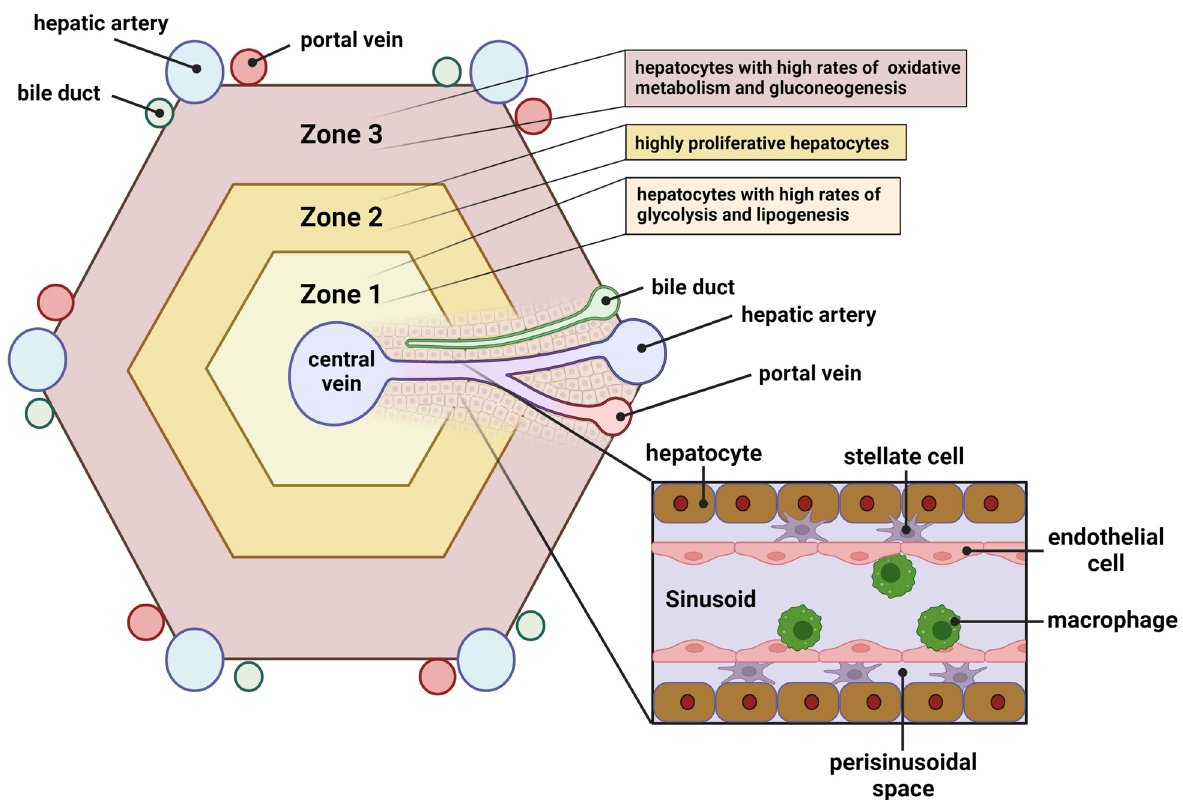
Figure 2. Liver lobule and hepatocyte zonation. The schematic depicts a hepatic lobule with hepatocytes residing in zones 1–3 along the length of the hepatic artery. Hepatocytes in different zones are known to display different metabolic phenotypes. Inset shows the sinusoidal and perisinusoidal space with the typical non-parenchymal resident cells. Created with BioRender.com.